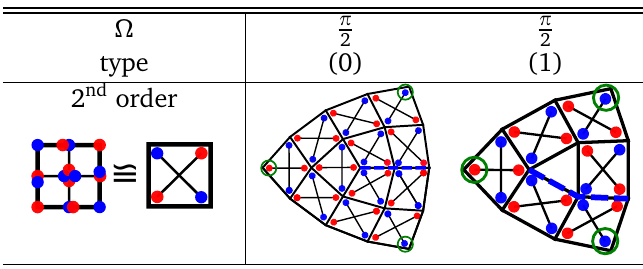
Figure C.5: Decoration of a fourfold symmetric lattice with π/ 2 disclinations of both types with strong second-order topological phases with (cid:90) anomalous boundary state. The first row shows the corresponding topological crystals. For simplicity, the anoma- lous bound states that hybridize within the unit cell are not shown.